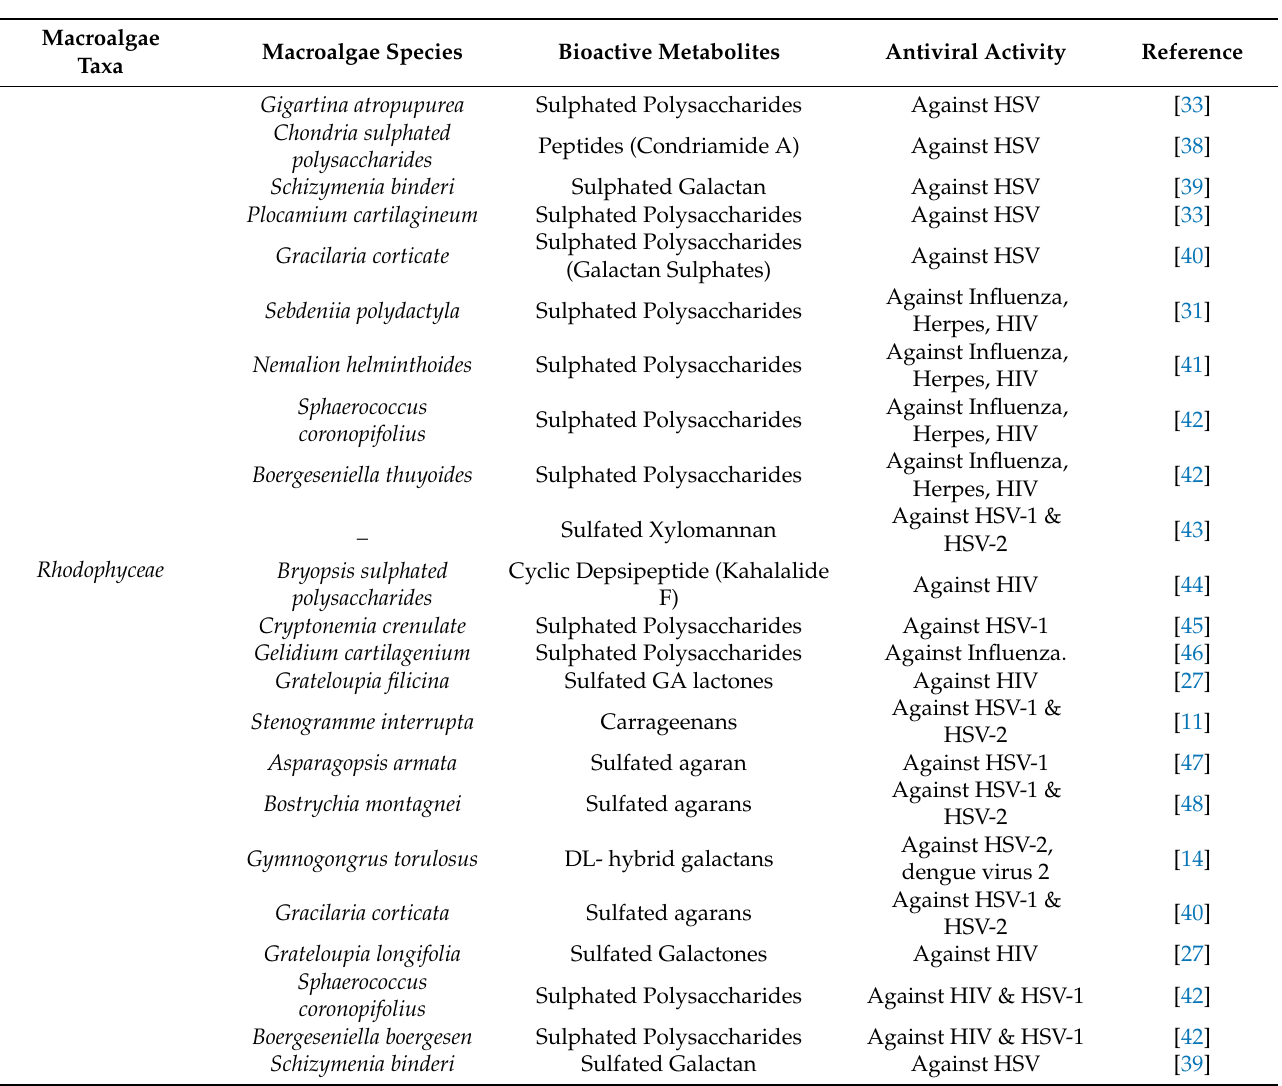
Table 2. A review of antiviral activity of macroalgae— Rhodophyceae